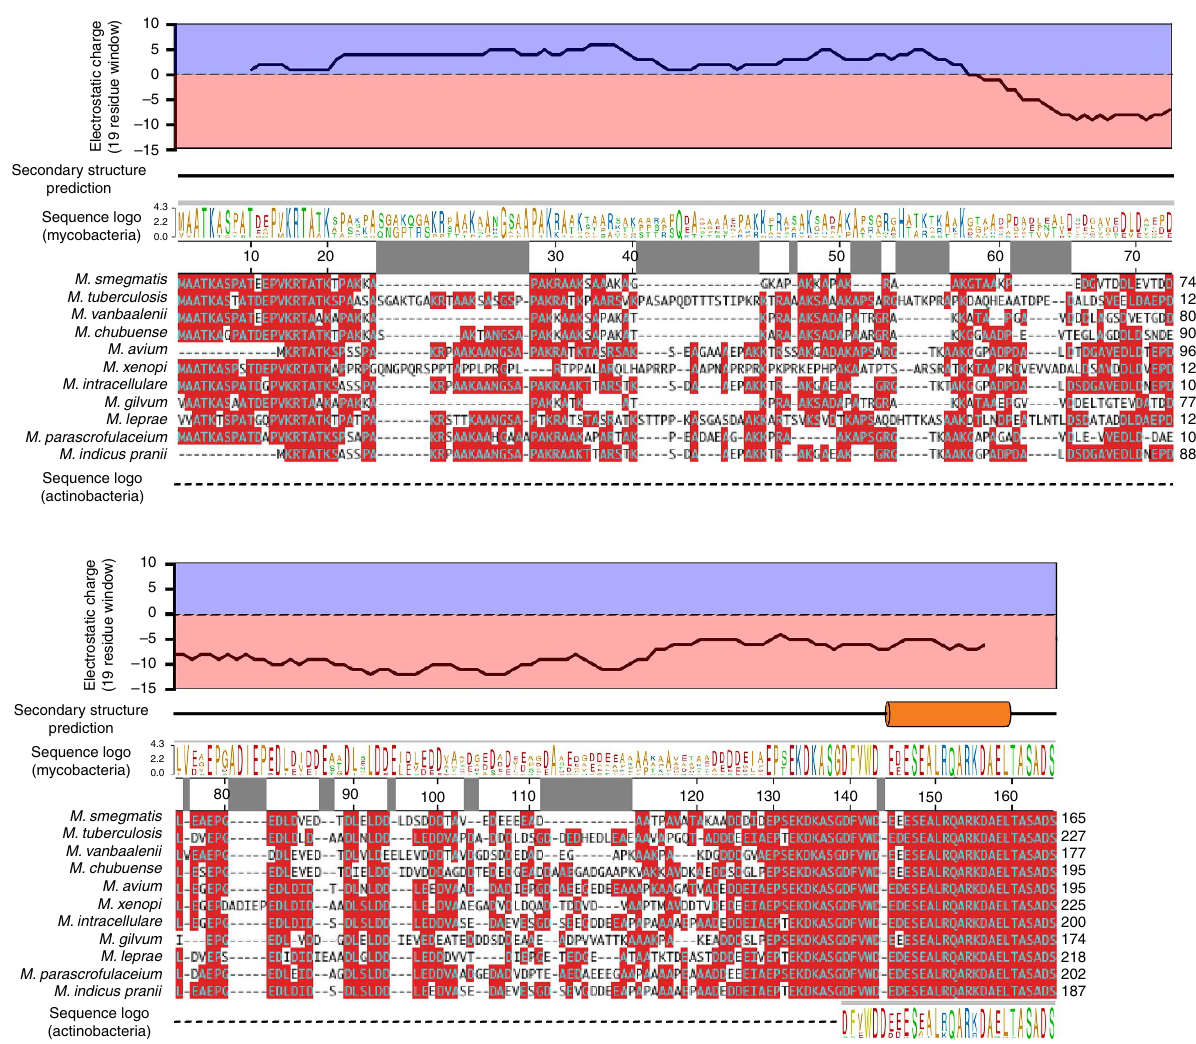
Figure 5 | Sequence characteristics of the s A N of mycobacteria and Actinobacteria. The Msm s A N (163 residues N-terminal of conserved region 1.2 (ref. 68)) is aligned with representative mycobacteria s A N sequences (the number scale on top of the alignment shows the Msm s A numbering). Residues conserved in more than half of the sequences are shaded red. The sequence logo 67 shown above was derived from an alignment containing 45 mycobacteria s A N sequences. The predicted secondary structure 48,49 for the Msm s A N is shown schematically above the logo. One a -helix is predicted ( Msm s A N residues 144–159, orange cylinder), with the rest of the sequence lacking any secondary structure. The net electrostatic charge of the derived consensus sequence, calculated in a 19-residue window, is plotted at the top (net positive charge is shaded blue, negative charge shaded red). A sequence logo derived from the Msm s A N with 199 Actinobacteria s A N sequences (excluding other mycobacteria sequences) is shown below. The region corresponding to Msm s A N residues 139–165, which includes the predicted a -helix, was conserved with all Actinobacteria s A N sequences, while Msm s A N residues 1–138 (the region predicted to lack secondary structure) showed no sequence relationship with other Actinobacteria s A N sequences (except for other mycobacteria s A N sequences) and could not be